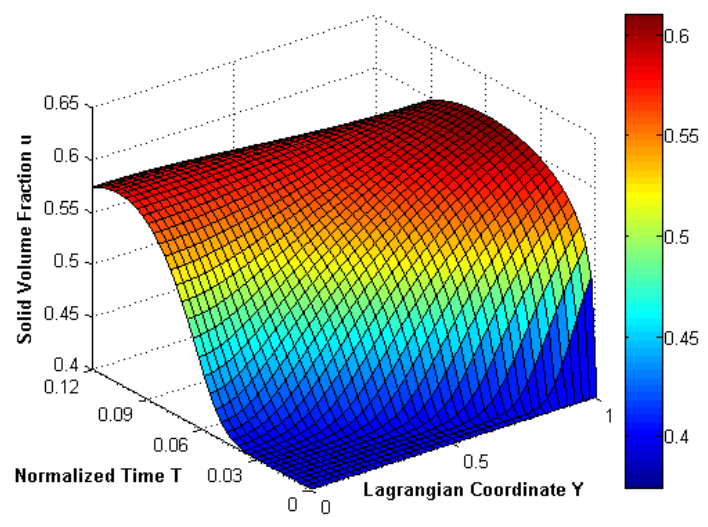
Figure 6. Solid volume fraction as a function of Lagrangian coordinate Y and normalized time T for T ) pressure p ( T ) = 1.25sin ( 50 π 6